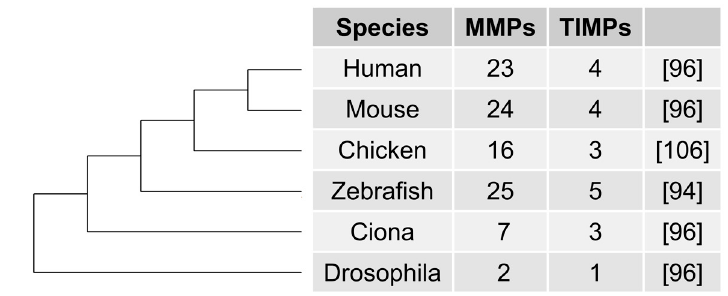
Figure 2. Literature distribution by keyword searches for the several most common names of the family of MMPs. Scale represents 0–10,000 hits in PubMed.